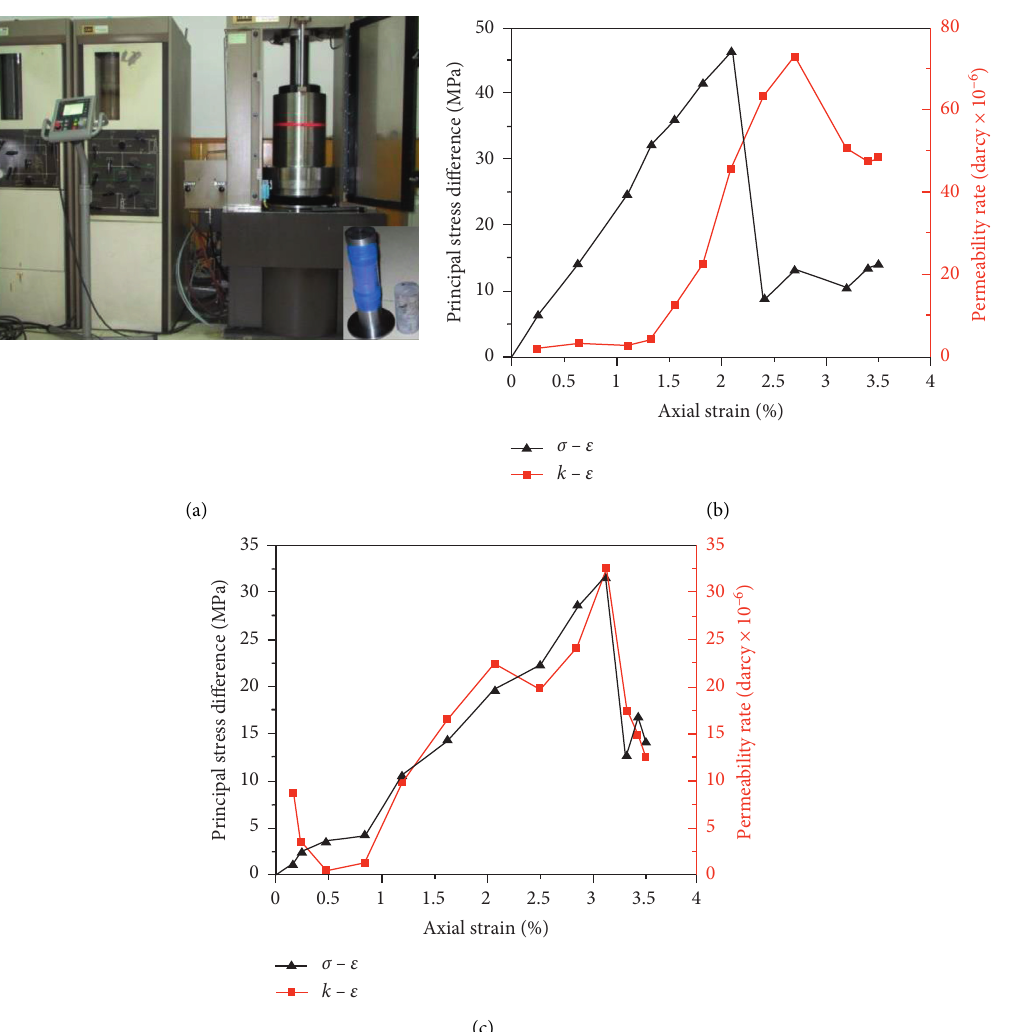
Figure 1: Permeability variations of the hard and soft rocks. (a) Electrohydraulic servocontrolled testing system; (b) hard rock: fine sandstone; (c) soft rock: